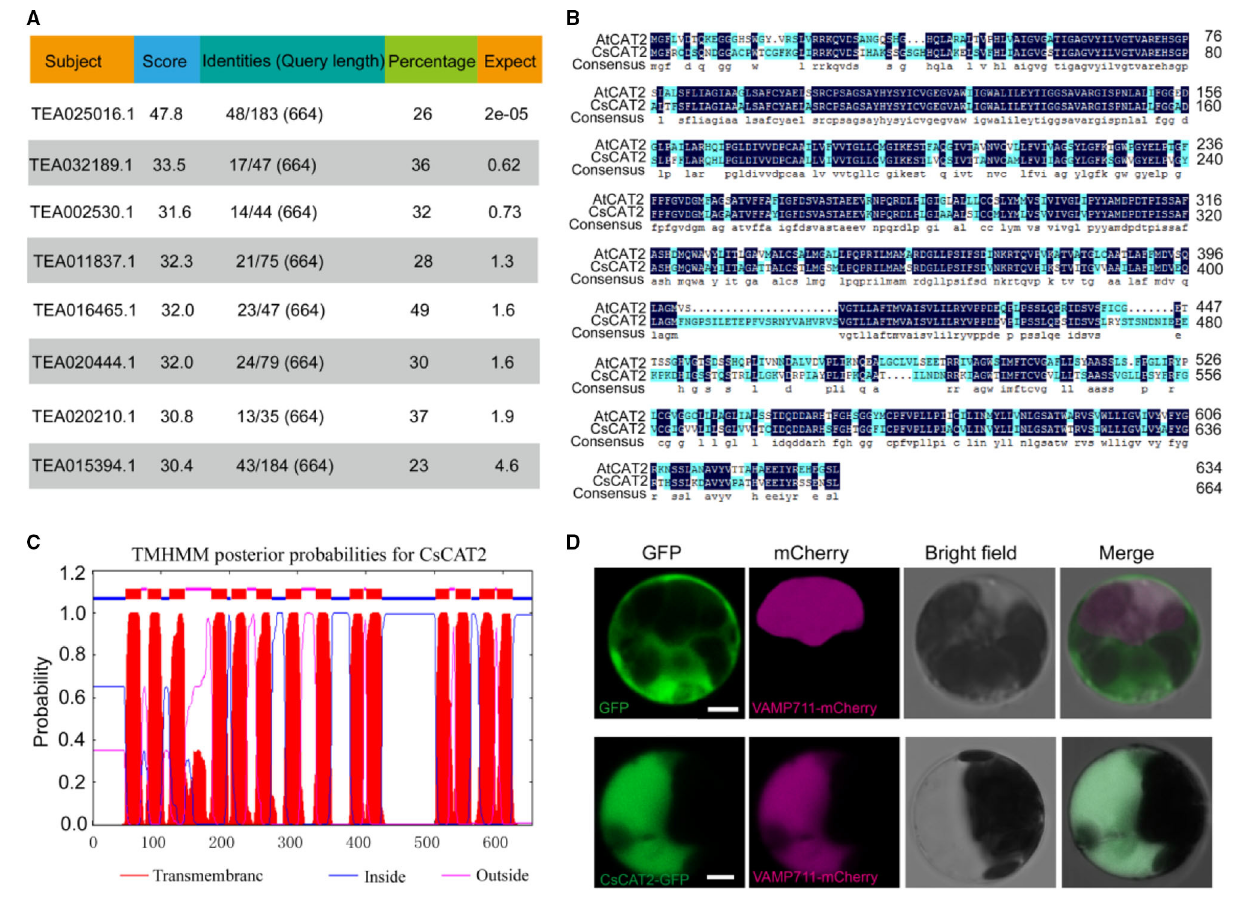
carbon source. Yeast cultured to an OD 600 of 0.6 was diluted to 10 0 , 10 − 1 , 10 − 2 , 10 − 3 , or 10 − 4 solutions. However, 2 µ